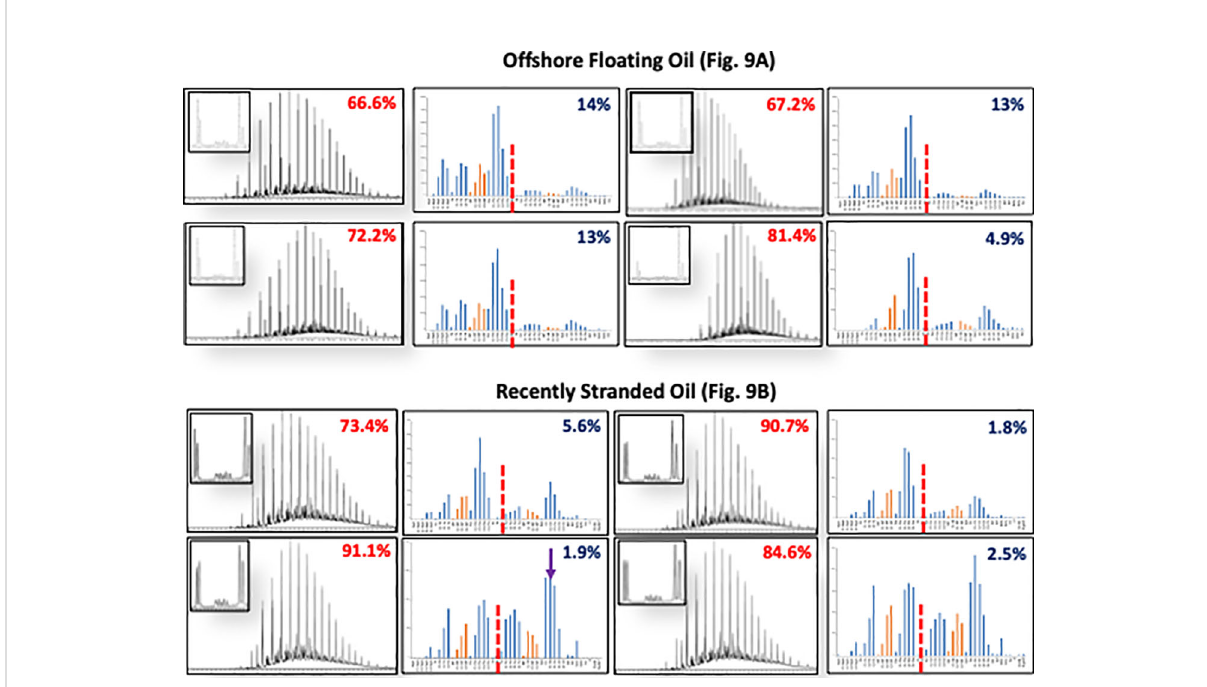
FIGURE 9 Compositional pro fi les of typical oil residues collected fl oating near the mouth of Mississippi River (A) and stranded oil residues on the shoreline of Bay Jimmy Louisiana (B) in 2010. The numbers in red are the hopane calculated depletion of the hydrocarbon residues compared to source liquid oil samples collected from the riser pipe. Similarly, the numbers in blue are the ratios of the sum of the target aromatic to total targeted aromatic and alkane hydrocarbons which is around 13% in the riser oil sample. The n-C 17 /pristane and n-C 18 /phytane ratio in fl oating oils show little change from that found in the liquid riser oil, implying essentially no biodegradation in fl oating oil (the top left inserts in each chromatogram). The same ratios found in stranded oil residues show signi fi cant depletion of the normal alkanes ( fi rst peak of each doublet) when compared to the pristine and phytane peaks (second compound in each doublet) indicating microbial depletion of normal alkanes in preference to isoprenoid alkanes. The stranded oil had lost signi fi cantly more of the two and three ringed PAH compounds relative to the four ringed PAH compounds when compared to fl oating oil